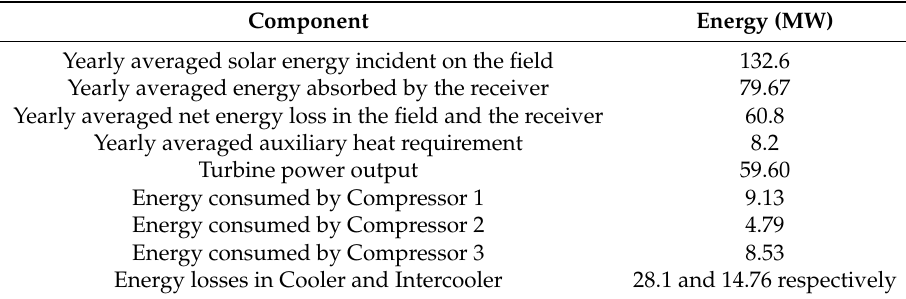
Table 4. Energy balance of the power plant operating at a turbine inlet temperature of 600 ◦ C.